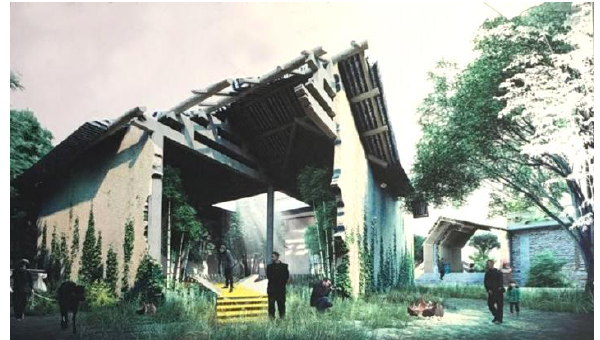
Figure 17. Narrative of place memory (Source: [45]).